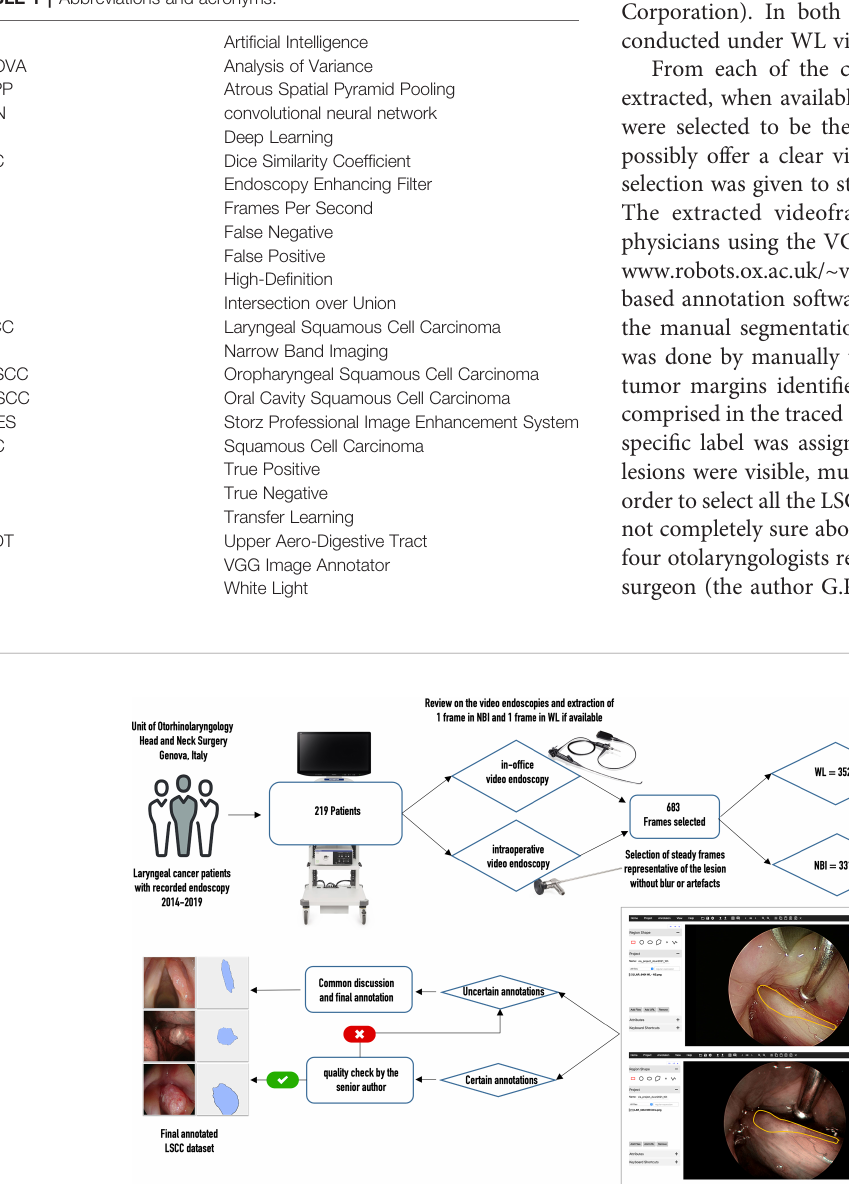
TABLE 1 | Abbreviations and